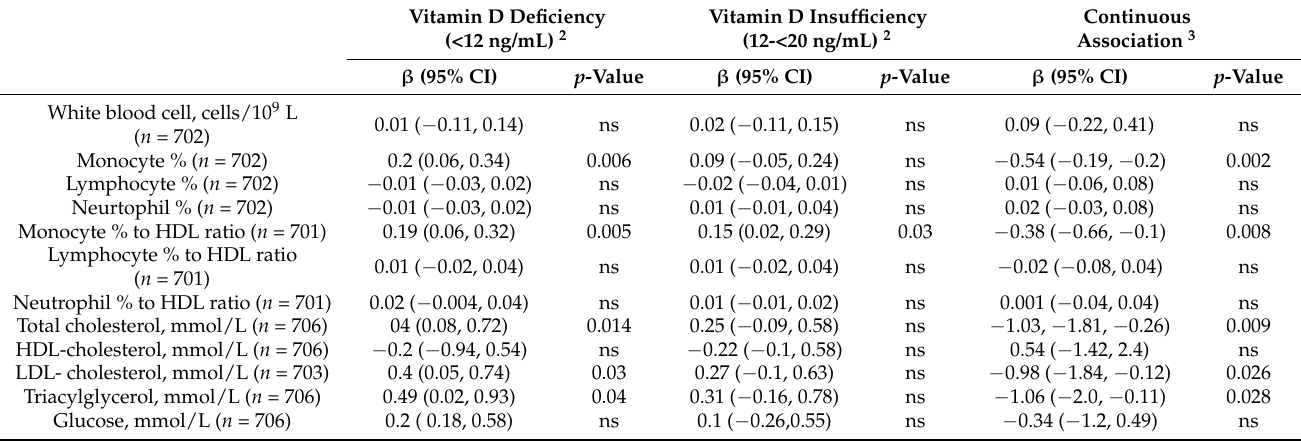
cantly associated with serum 25(OH)D. Plasma glucose was not significantly assocaited with serum 25(OH)D concentrations. Table 2. Association between serum 25(OH)D concentrations and inflammatory markers and serum lipids in young healthy adults in Qatar 1 .